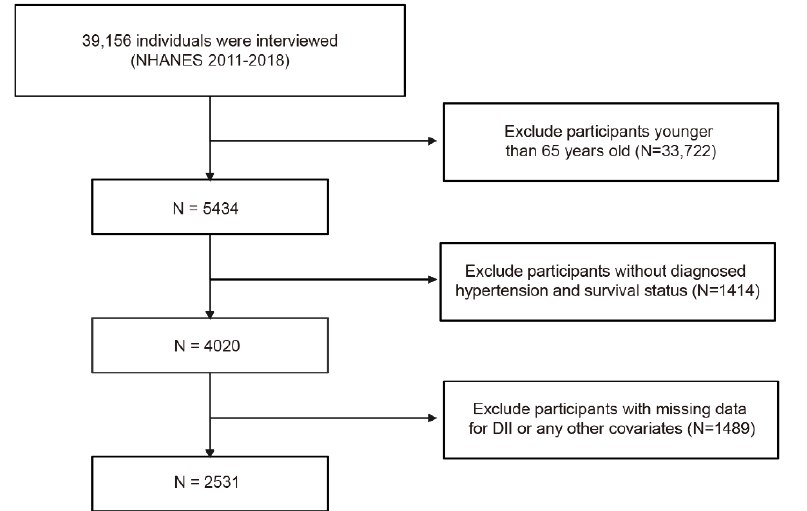
Figure 1. Flow diagram for inclusion of the study population. Table 1. Baseline characteristics of